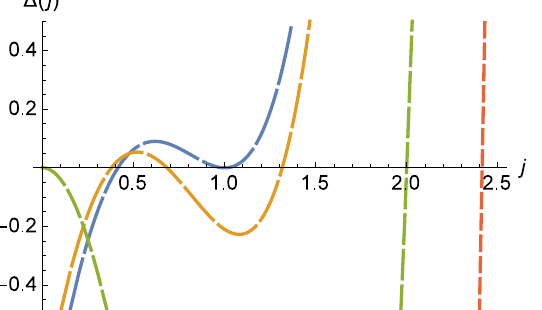
Figure 6. Zoomed-in view of Figure 5 showing the same determinant ∆ ( j ) = − 4 a 2 + 8 aj − 4 j 2 + j 4 for values a = 0.5 (blue upper line), 0.45 (yellow line), a = 0 (green line), and a = − 0.5 (red line). It is apparent that with a certain combination of parameters— j -rotation of the test body around the black hole and proper a -rotation of the black hole—there arises a "window of transparency" where ∆ ( j ) > 0. However, for such window u 1 > 1, the noted flyover regime does not become realized in the region 0 ≤ u ≤ 1, i.e., outside the ergosphere. √ For j = 1 + 2 − β when β → + 0, near u (cid:39) 0.343, change of angle φ occurs most rapidly